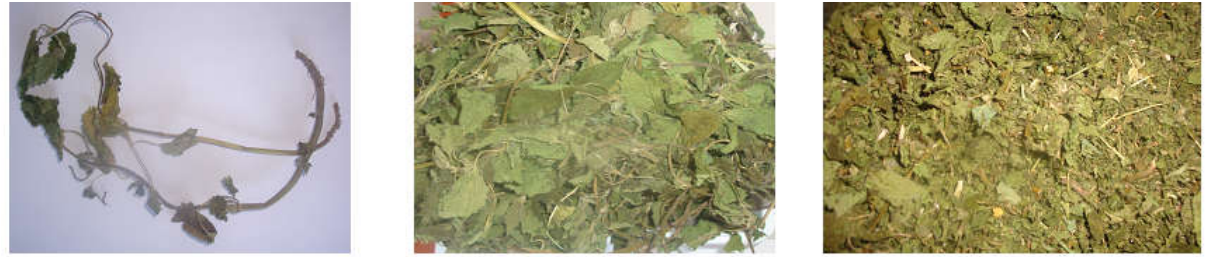
Figure 1. Dried whole nettle, bulk nettle, and chopped